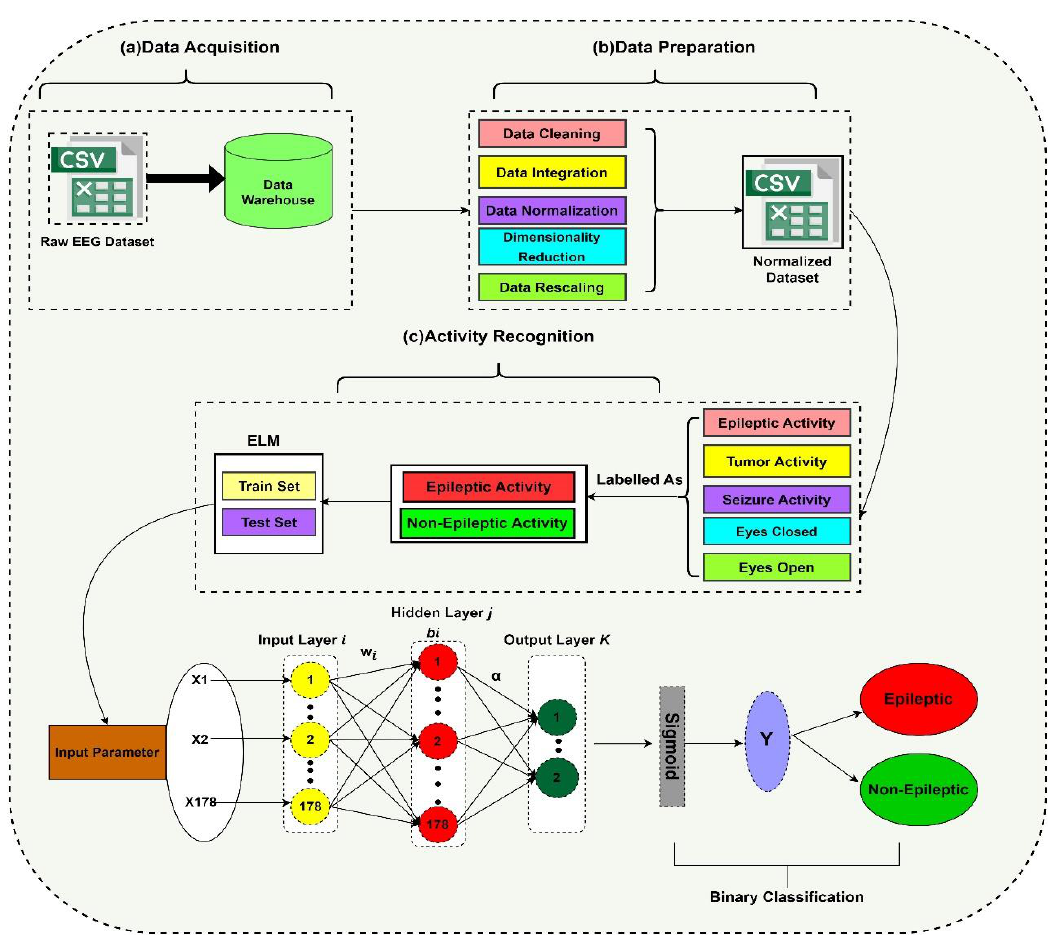
Figure 1. Proposed